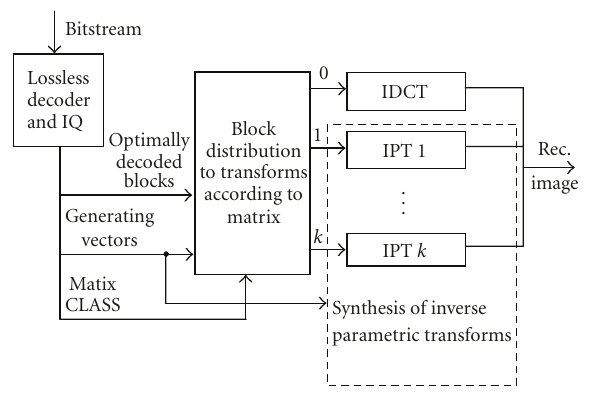
Figure 6: General scheme of an image decoder for two proposed compression